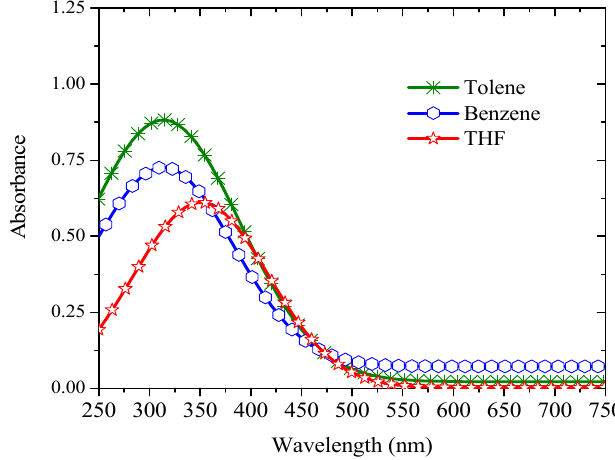
Figure 3. Absorption spectra of PFO-co-pX in different solvents such as toluene, THF, and benzene at a 90 μ M concentration.